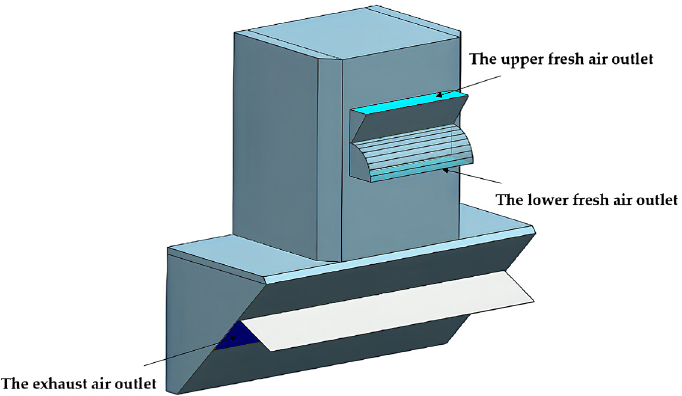
Figure 1. Fresh air system for extractor hoods .